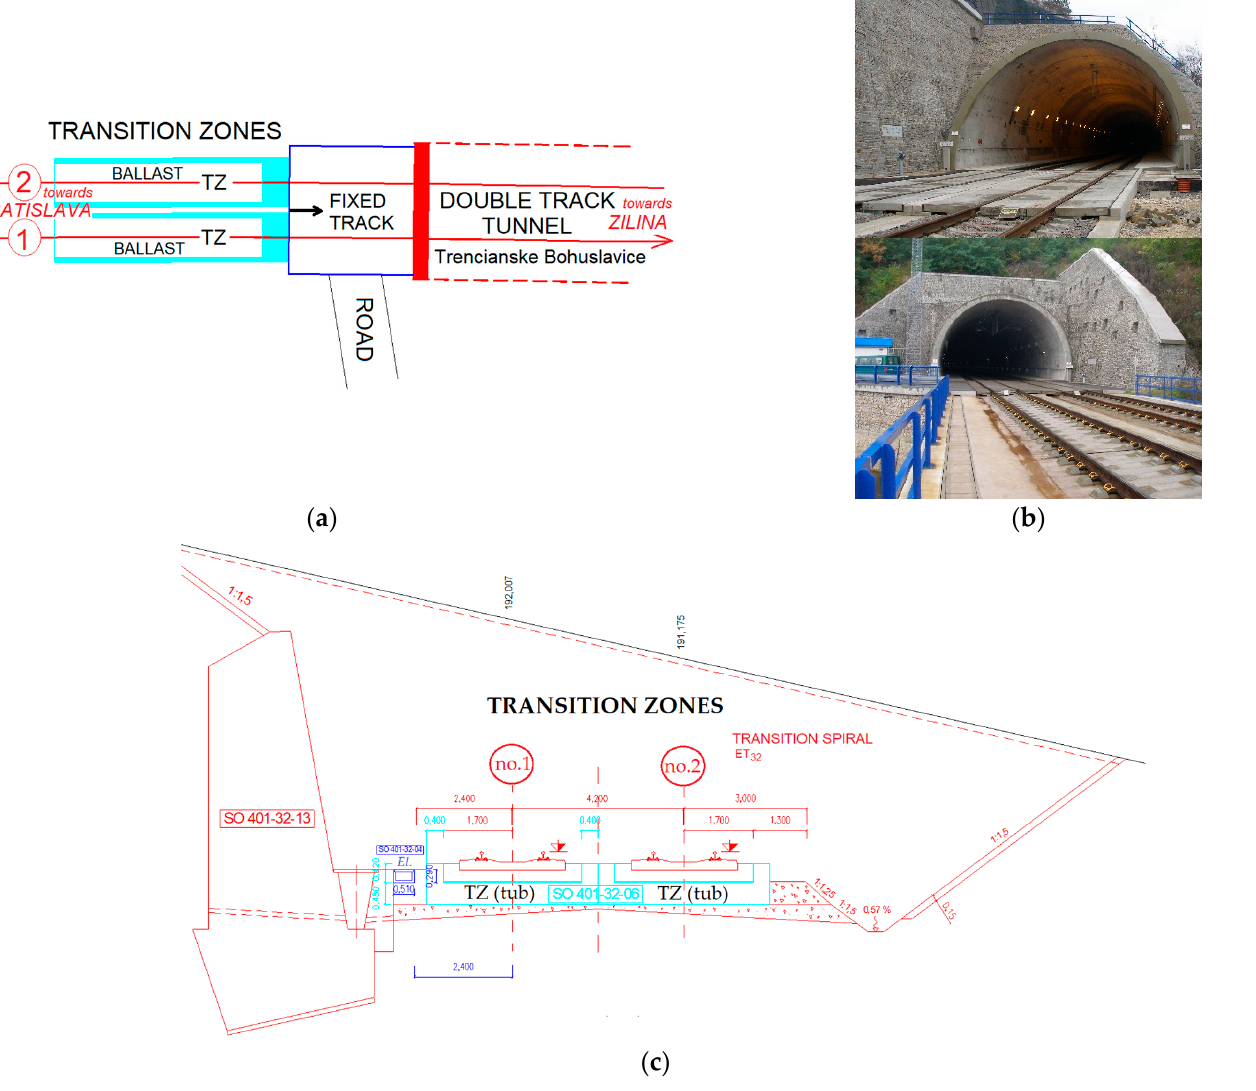
Figure 5. Railway tunnel Trencianske Bohuslavice V = 200 km/h [13]: ( a ) Situation of TZ; ( b ) Photo: TZ in front of the tunnel and bridge with a fixed track [Hodas]; ( c ) Designed cross-section with TZ in [15].